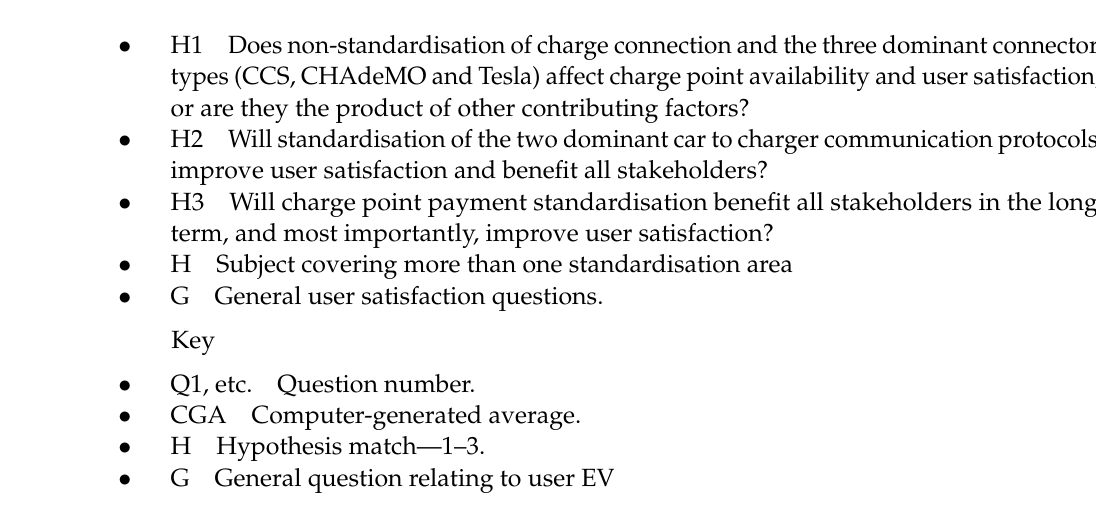
Figure 29. Dominant results from each survey